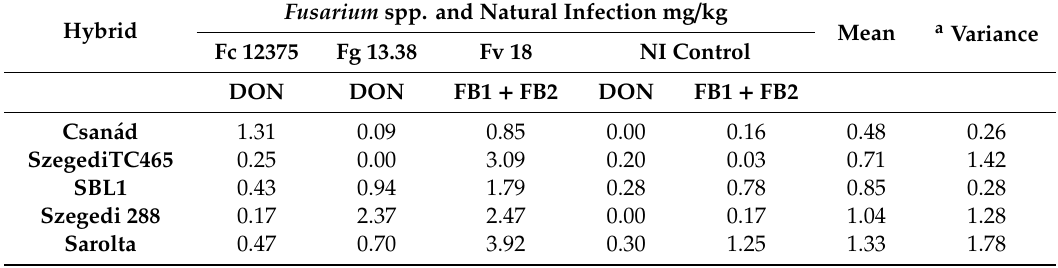
Table 9. Toxin contamination following toothpick inoculation in 2010–2011 in maize hybrids (kernel resistance), data in mg / kg,